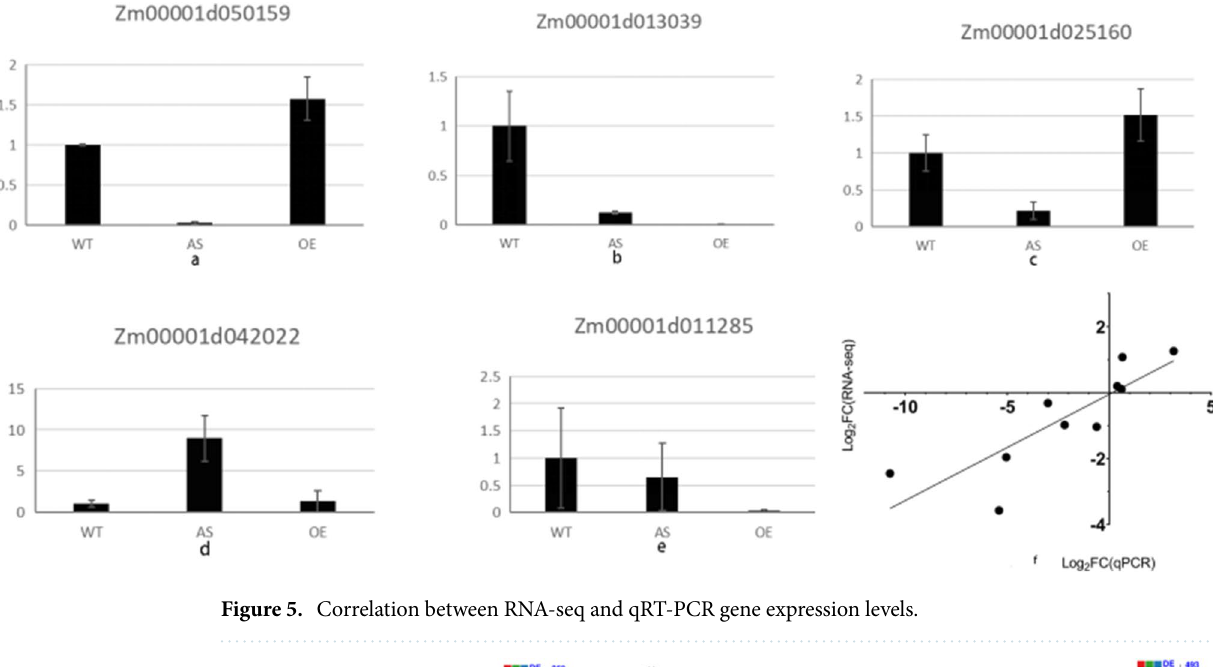
Figure 5. Correlation between RNA-seq and qRT-PCR gene expression levels.